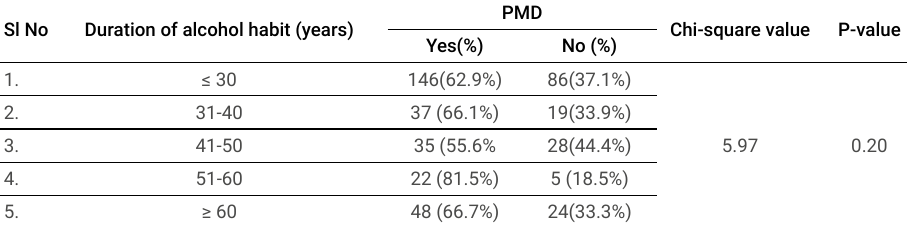
Table 5. Distribution of subjects according to duration of alcohol drinking and PMD Sl No Duration of alcohol habit (years)